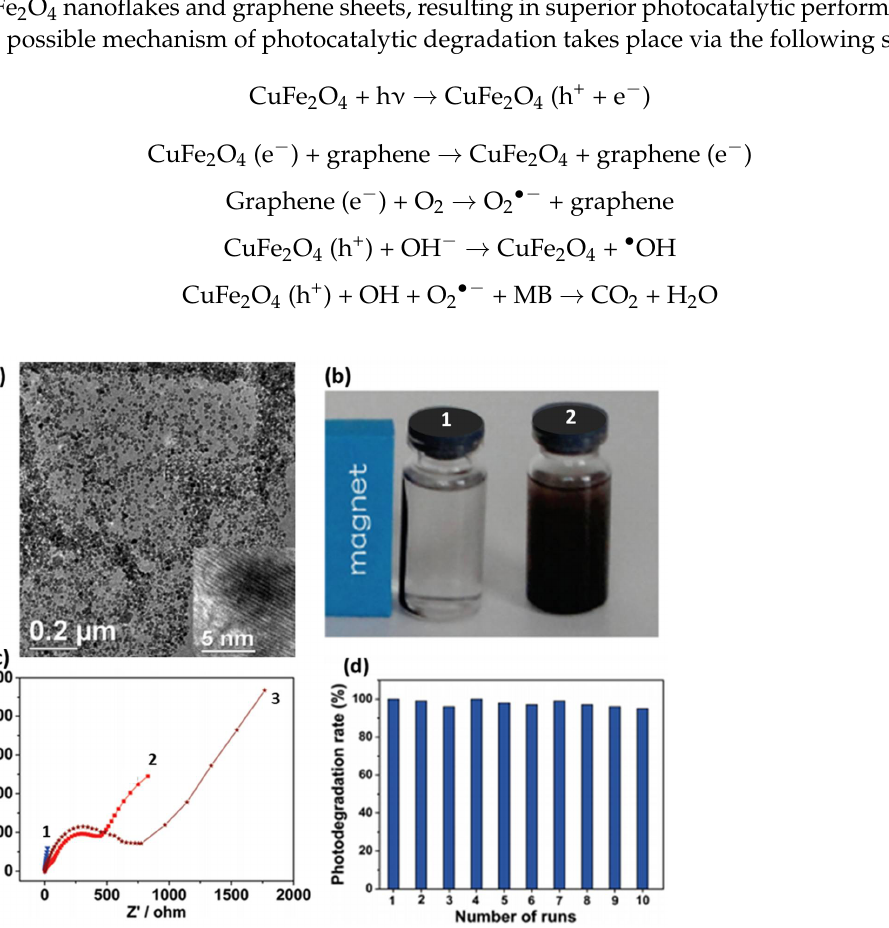
Figure 8. ( a ) Uniform dispersion of ZnFe 2 O 4 nanoparticles over graphene ( b ) Images of ZnFe 2 O 4 graphene suspension with (1) and without (2) magnetic field, ( c ) EIS of (1) ZnFe 2 O 4 graphene, (2) pure ZnFe 2 O 4 and (3) GO and ( d ) stability test shown by photodegradation rate of MB using ZnFe 2 O 4 -G for 10 cycles. Adapted with permission from [192]. Copyright 2011, American Chemical Society.